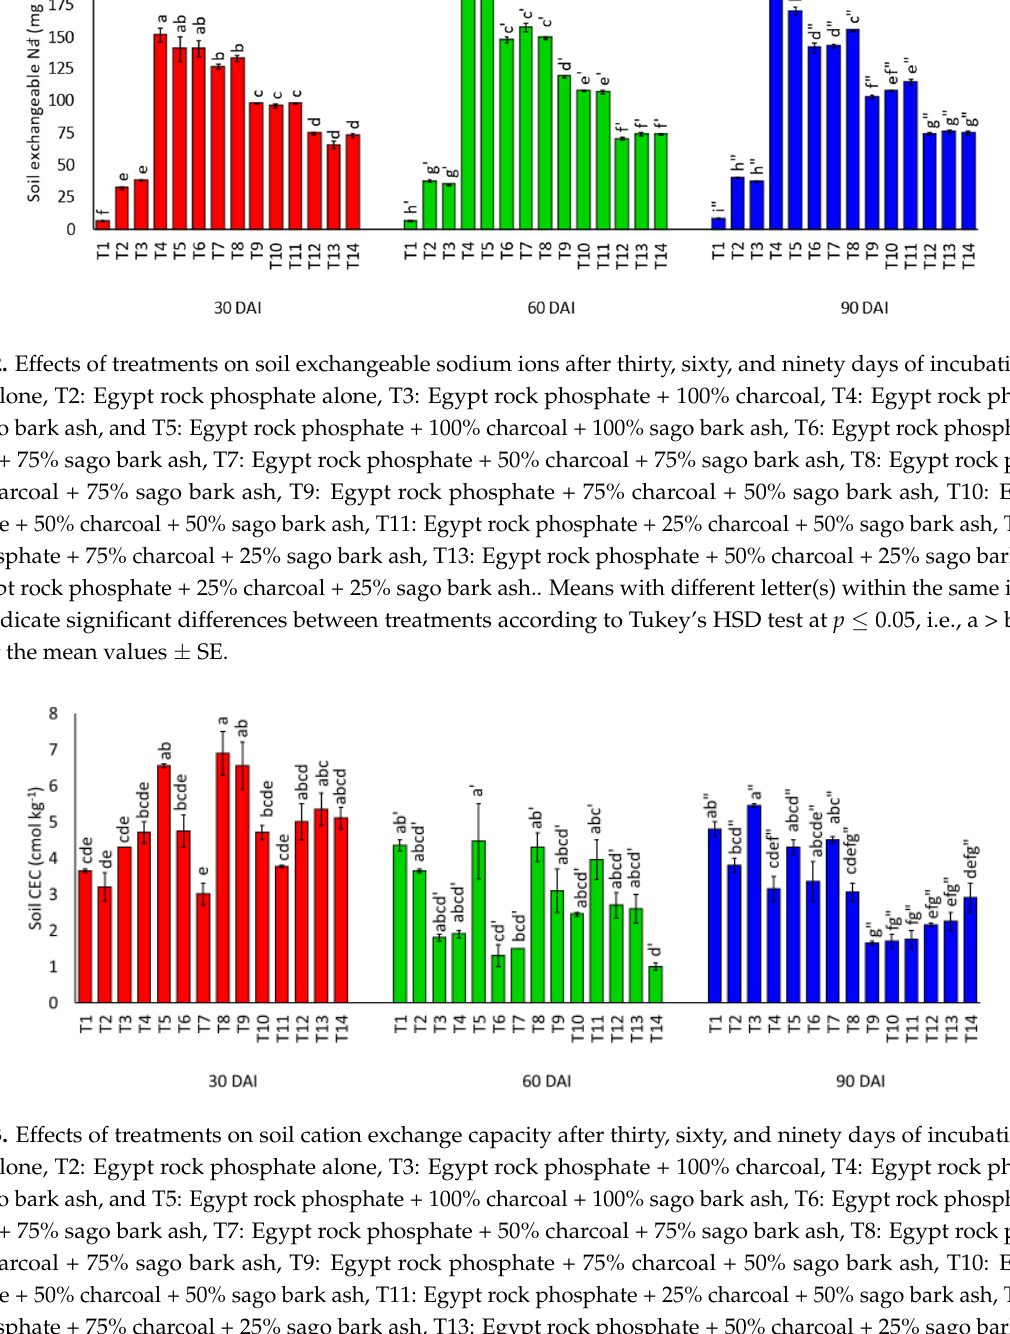
13 of 28 Figure 11. Effects of treatments on soil exchangeable magnesium ions after thirty, sixty, and ninety days of incubation, where T1: soil alone, T2: Egypt rock phosphate alone, T3: Egypt rock phosphate + 100% charcoal, T4: Egypt rock phosphate + 100% sago bark ash, and T5: Egypt rock phosphate + 100% charcoal + 100% sago bark ash, T6: Egypt rock phosphate + 75% charcoal + 75% sago bark ash, T7: Egypt rock phosphate + 50% charcoal + 75% sago bark ash, T8: Egypt rock phosphate + 25% charcoal + 75% sago bark ash, T9: Egypt rock phosphate + 75% charcoal + 50% sago bark ash, T10: Egypt rock phosphate + 50% charcoal + 50% sago bark ash, T11: Egypt rock phosphate + 25% char- coal + 50% sago bark ash, T12: Egypt rock phosphate + 75% charcoal + 25% sago bark ash, T13: Egypt rock phosphate + 50% charcoal + 25% sago bark ash, and T14: Egypt rock phosphate + 25% charcoal + 25% sago bark ash. Means with different letter(s) within the same incubation period indicate sig- nificant differences between treatments according to Tukey’s HSD test at p ≤ 0.05, i.e., a > b > c. Bars represent the mean values ± SE. Throughout the incubation study, T1 showed the lowest soil exchangeable Na + com-